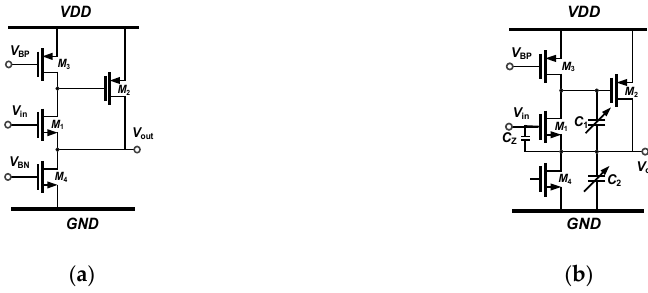
Figure 2. Schematics of ( a ) NMOS-input super-source-follower (SSF) and ( b ) SSF-based biquadratic low-pass filter.